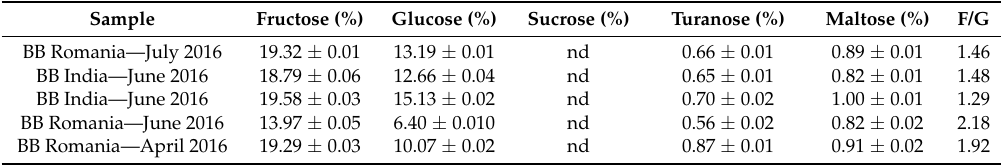
Table 2. Sugar content and ratio of F/G in the various samples of BB